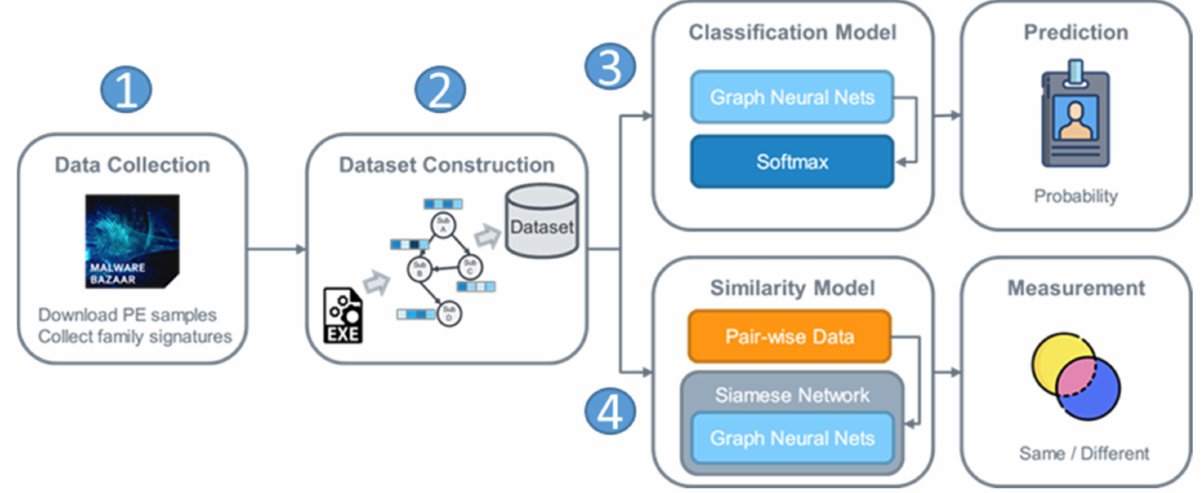
Figure 1. Proposed architecture.